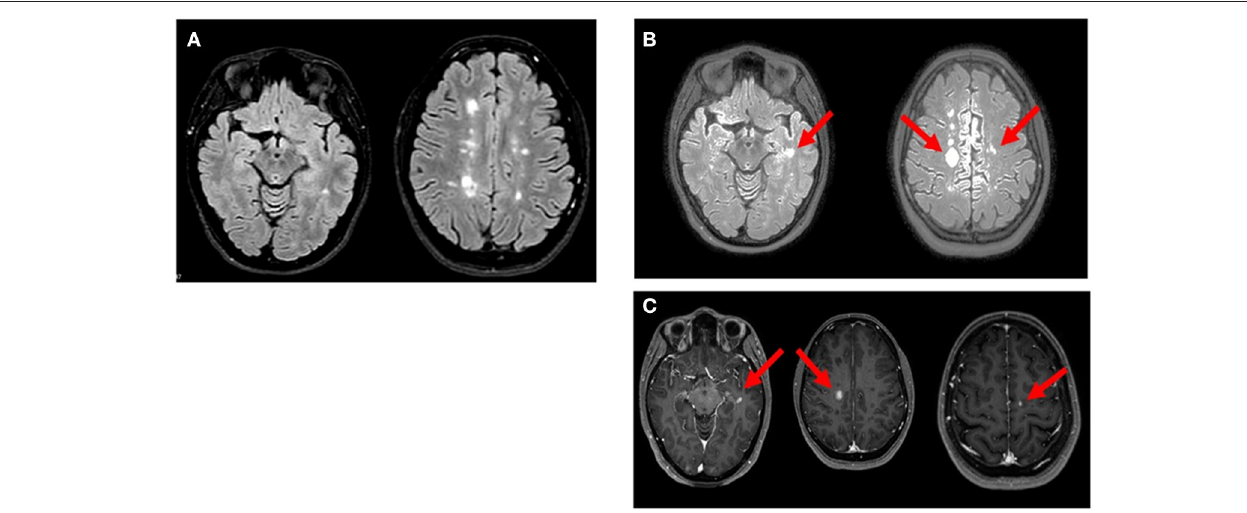
FIGURE 1 | Axial MRI images of reported patient. ( A ; Oct 2020) : multiple hyperintense white matter lesions were observed in T2/FLAIR weighted scan. ( B ; Apr 2021) : T2/FLAIR weighted scan showed new three lesions in left temporal lobe and bilateral precentral cortex (arrows). ( C ; Apr 2021) : gadolinium-enhancing lesions (arrow) corresponding to the new hyperintense lesions on FLAIR were noted in T1 weighted postcontrast